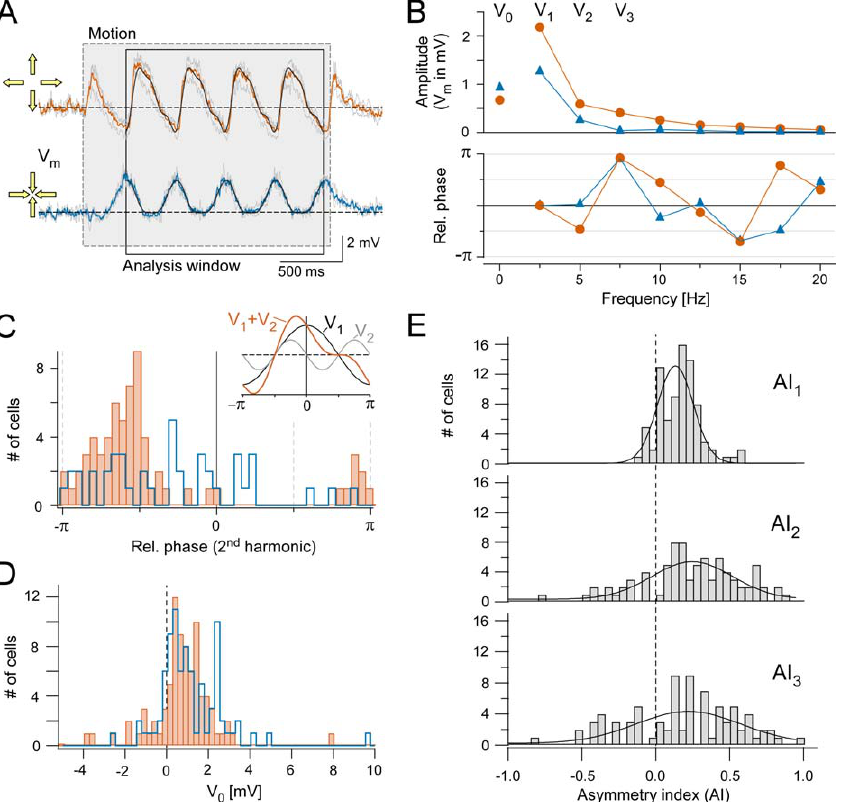
Figure 2. Quantification by Fourier Decomposition (A) Voltage responses evoked by circular wave stimuli; gray: individual trials, orange and blue: averages for CF and CP motion, respectively; black: reconstructed waveforms; frame: trace segment used for analysis ( V Rest ¼(cid:2) 60 mV). Gray area indicates motion duration. (B) Amplitudes (top) and relative phases ( / 2 (cid:2) 2 (cid:3) / 1 , bottom) versus frequency (f ) for the averaged responses in (A). Symbols ( V 0 at f ¼ 0; V 1 at f 1 ; V 2 , V 3 ... at 2 (cid:3) f 1 , 3 (cid:3) f 1 ,...) are measured points; connecting lines are only a guide for the eye. Note that the phases for the CF motion decrease linearly except when wrapping around (at (cid:2) p , p ). Reconstructions of the waveforms using V 0–3 and their phases shown as black traces in (A). (C) Histogram of the relative (rel.) phase shift ( / 2 (cid:2) 2 (cid:3) / 1 ) between fundamental and second harmonic (orange for CF, n ¼ 65; blue for CP motion, n ¼ 41 cells; only cells with V 2 (cid:4) 0.3 mV included; stimulus: 2.5–3 Hz; 46%–73% contrast; period: 192 l m). Inset: fundamental and second harmonic generate a steeply rising flank when the relative phase is close to (cid:2) p /2. (D) Distribution of V 0 ( n ¼ 83, same cells as in [C]) for CF (orange) and CP motion (blue). (E) Distribution of asymmetry indices, AI 1 , AI 2 , and AI 3 ( n ¼ 83 cells; all AI s are significantly different from zero with p AI1,AI2,AI3 (cid:5)